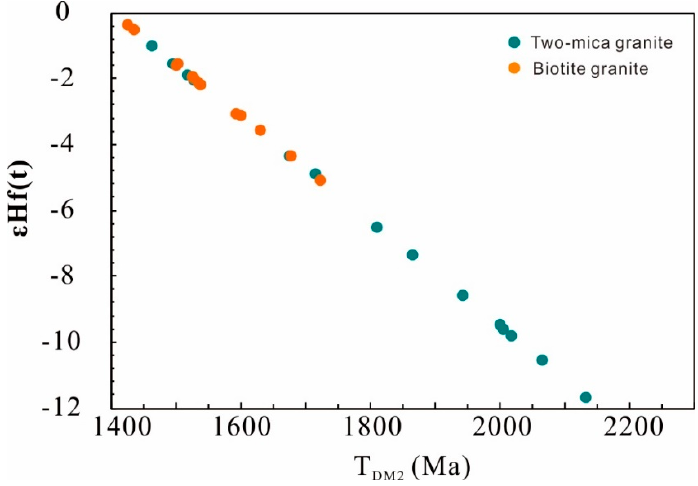
Figure 7. T DM2 vs. ε Hf ( t ) of zircons from the Nashwaak Granite.